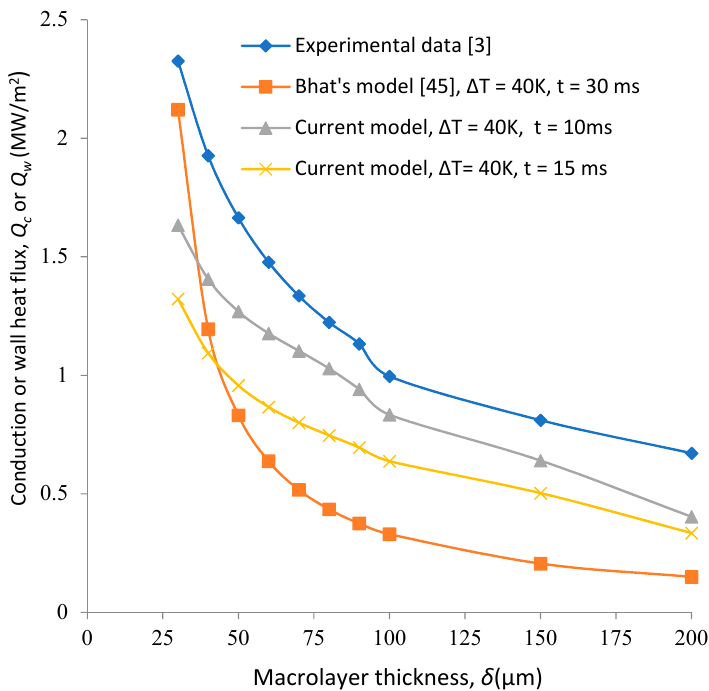
Figure 8. Comparative analysis of predicted heat fluxes with experimental data.